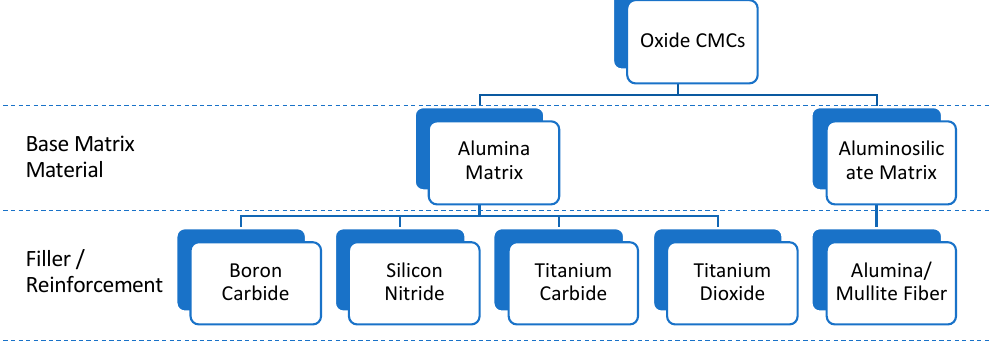
Figure 4. Oxide CMC material categories.